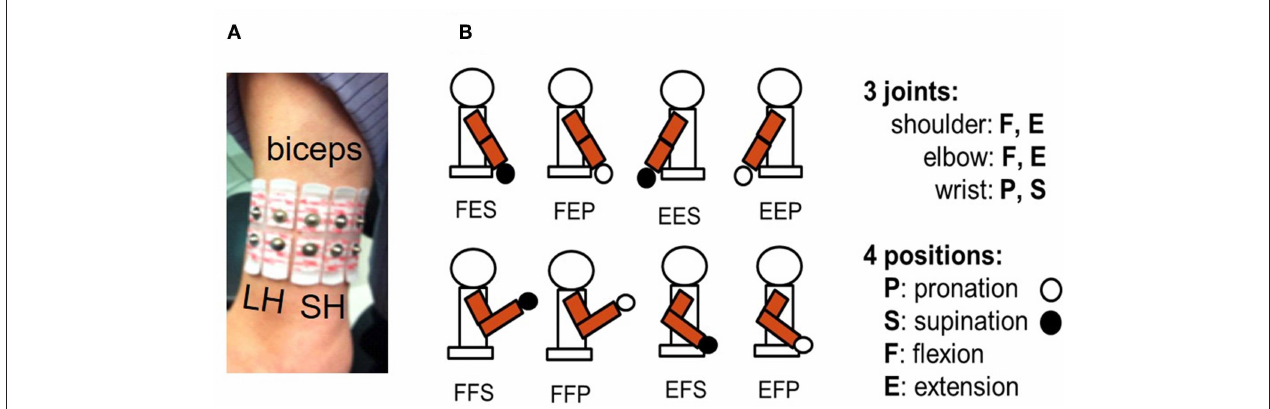
FIGURE 1 | (A) Five bipolar surface electrodes were placed across the biceps brachii: two over the long head (LH) and three across the short head (SH). (B) Eight different static postures of the right upper arm were used. They are identified with a 3-tuple system [*,*,*] respectively representing shoulder, elbow, and wrist joints. For the first * it can be F (flexion) or E (extension) for shoulder joint posture, second * can be F or E for elbow joint posture, and third * can be P (pronation) or S (supination) for wrist joint posture.